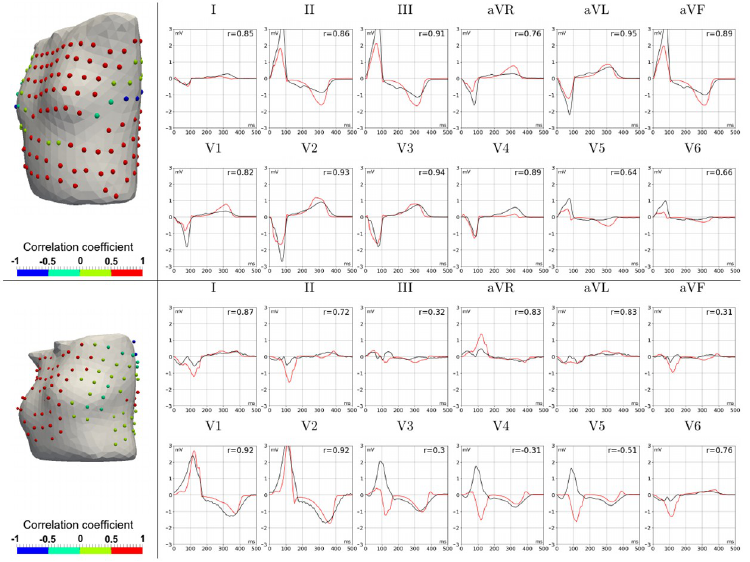
Fig 3. Comparison of simulated and patient ECGs in P1(LV) (upper panels) and P5(RV) (lower panels) patient- specific models. Color spheres in the left panels show CC values (see color-coding scale) for the BSM electrode array on the torso, and the right panels show simulated (red lines) and measured (black lines) ECG signals in standard 12-lead array. The top panel shows a good simulation of the P1(LV) patient data with high CC values (red spheres) in most BSM leads and good agreement between time-dependent signals in each standard lead. The bottom panel demonstrates the opposite QRS complexes in simulated and measured ECGs (see leads V3–V5) for the P5(RV) model as an example of possible simulation